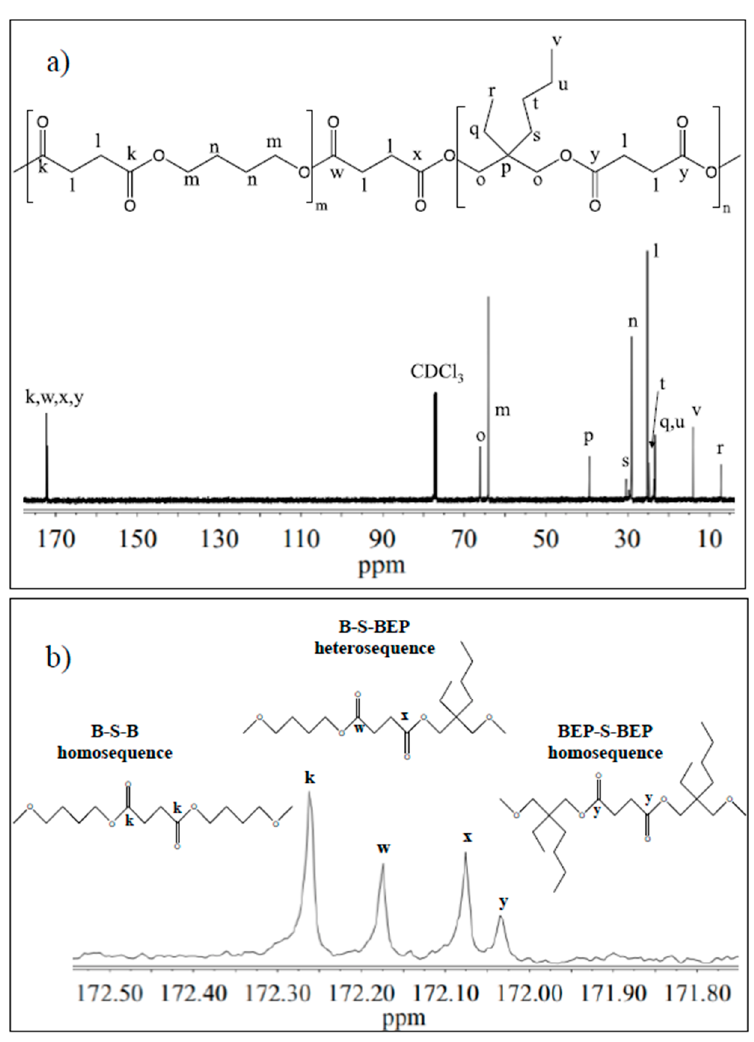
Figure 3. ( a ) 13 C–NMR spectrum of P(BS 70 BEPS 30 ) with resonance assignments; and ( b ) enlargement of 13 C–NMR spectrum in the region 172.50–171.80 ppm together with the schematic representation of B-S-B, B-S-BEP and BEP-S-BEP sequences. B-S-B, B-S-BEP and BEP-S-BEP